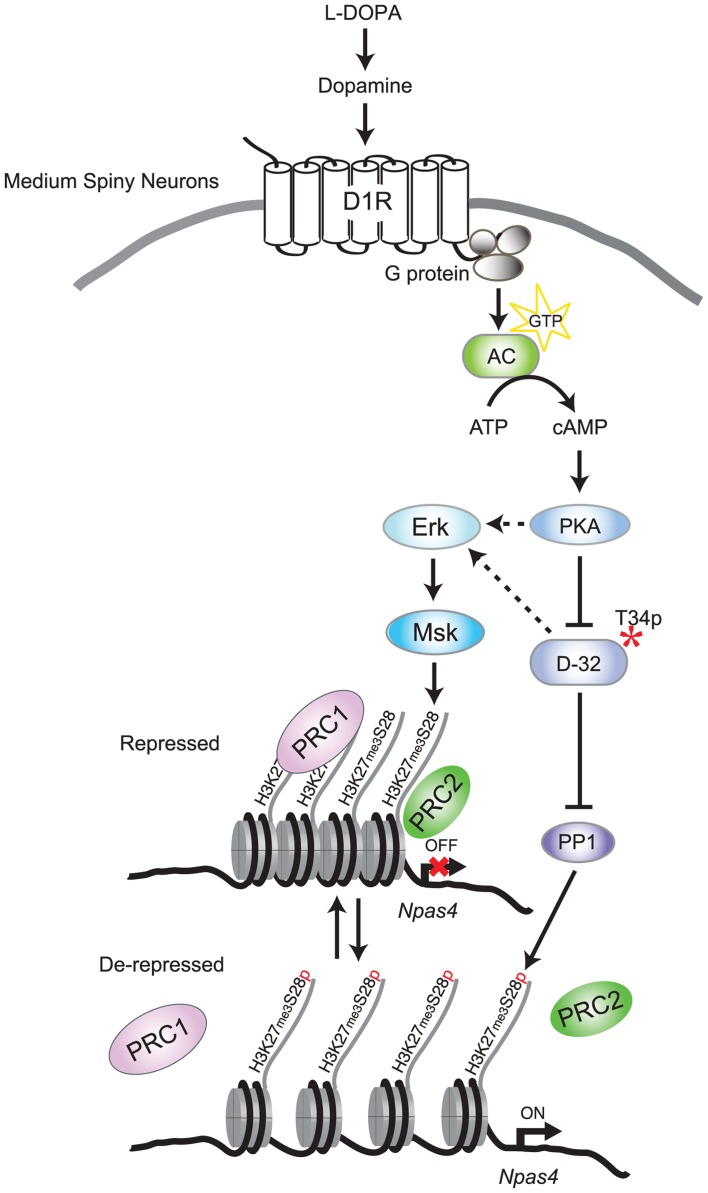
Model for L-DOPA induced signaling and H3K27me3S28 phosphorylation in MSNs of parkisonian mice.In 6-OHDA lesioned mice, L-DOPA is converted to dopamine which binds to sensitized D1Rs. Activation of D1Rs stimulates adenylate cyclase (AC), leading to increased cAMP and activation of PKA/DARPP-32 signaling, which promotes Erk phosphorylation. Erk activates Msk leading to H3K27me3S28 phosphorylation. In addition, PKA-mediated activation of DARPP-32 inhibits PP1, further increasing H3K27me3S28 phosphorylation. Augmented H3K27me3S28p leads to reduced binding of PcG complexes (PRC1 and PRC2), derepression of genes and eventually increased transcription depending on general transcription factors and RNA polymerase II (not included in this illustration for simplicity).